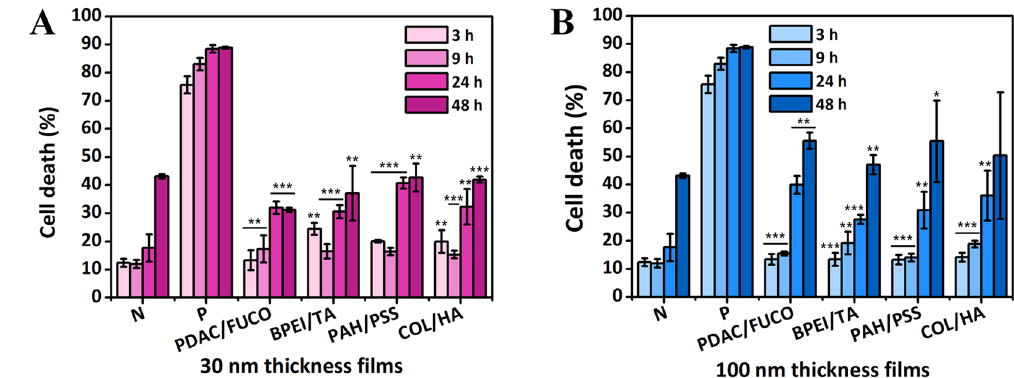
Figure 9. Cytotoxic effects of four types of LbL films with thicknesses of 30 and 100 nm on PBMCs. Cell death was investigated up to 48 h with films with thicknesses of ( A ) 30 nm and ( B ) 100 nm. N and P in each graph indicate the negative control and positive control, respectively ( * p < 0.05, ** p < 0.01, *** p < 0.001 with respect to 30% MeOH as the positive control; 56.25% of A and 75% of B , no significant difference from negative control; two-tailed t